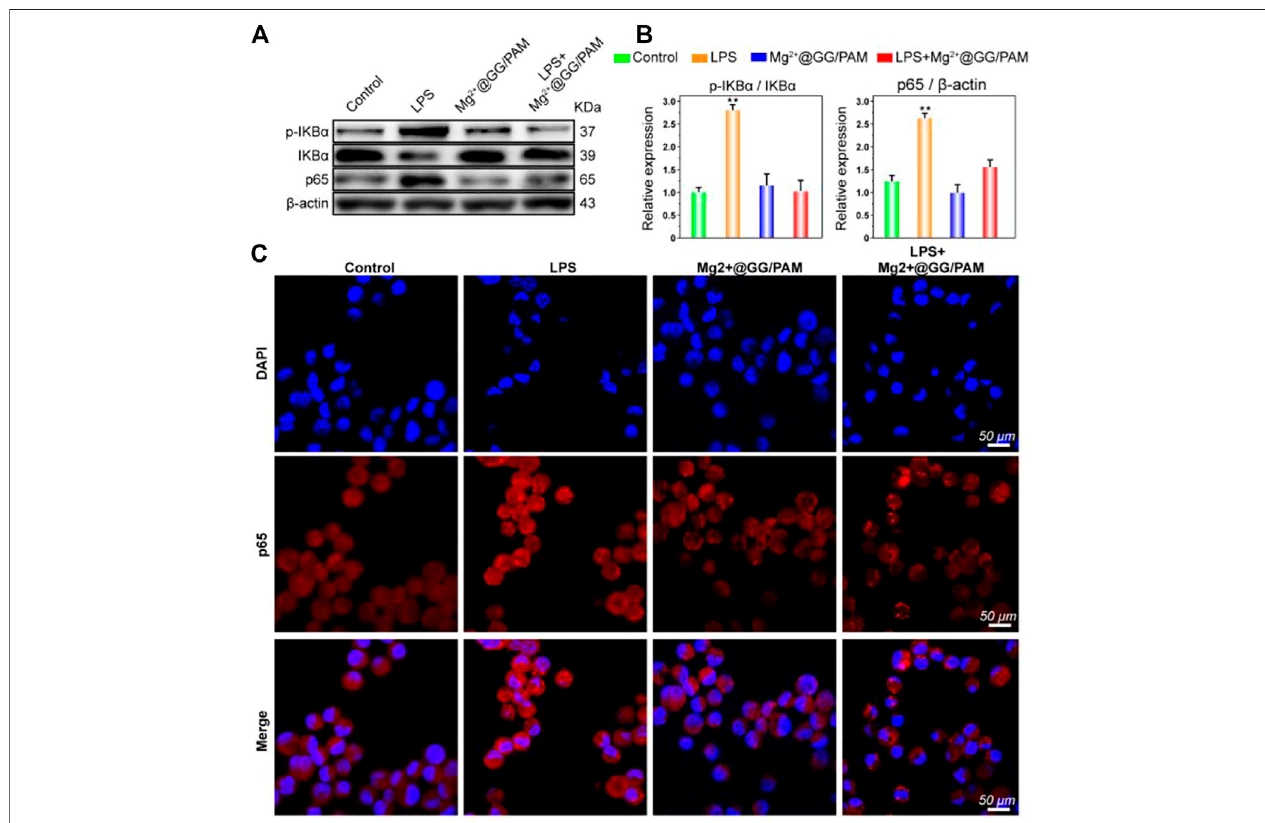
FIGURE 5 | The protein expression of NF- κ B p65 was detected by Western blotting after treatment with Mg 2+ @GG/PAM hydrogel and LPS (A) . The statistical analysisof p -IKB α ,IKB α ,andNF- κ Bp65expression (means ± SD, n (cid:1) 4). (B) RAW264.7 cellswerestainedwithanti-p65antibodyand DAPIafterculturingontocontrol, GG, GG/PAM, and Mg 2+ @GG/PAM hydrogel for 72 h and visualized by fl uorescence microscopy. (C) * p < 0.05, ** p < 0.01 vs control.